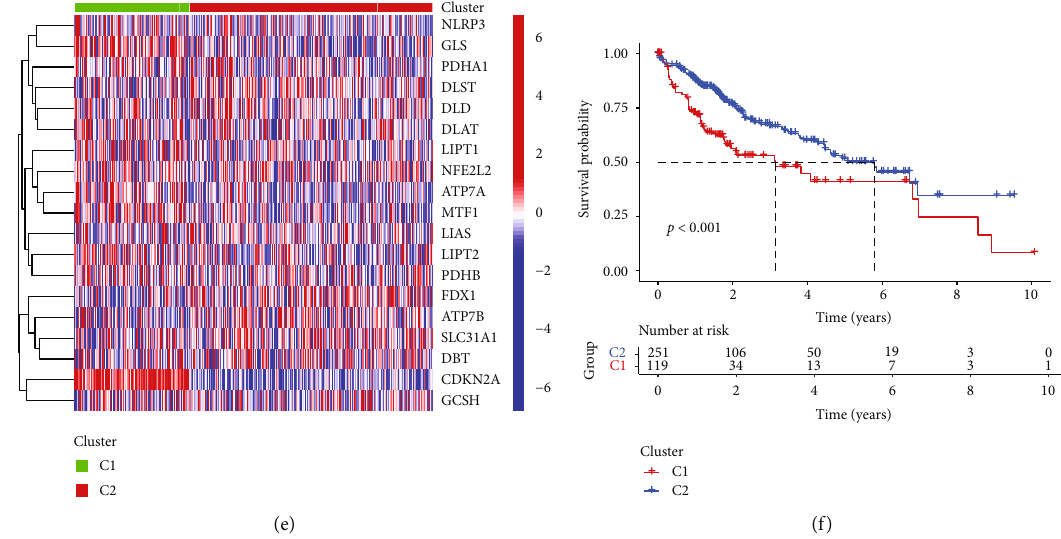
Figure 2: Consensus clustering of cuproptosis-associated subtypes and survival analysis in the TCGA. (a) Heatmap represented the consensus clustering solution ( k = 2 ) for 19 CRGs among 502 HCC samples. (b, c) The consensus clustering delta area showed the cumulative distribution function area for k = 2 to 9. (d) Boxplots represented gene expression pro fi les for 19 genes in the two clusters. (e) An expression heatmap showed 19 genes grouped into two clusters. The color legend represents the log2 (FPKM) value. Red highlighted the high expression, and blue highlighted the low expression. (f) Kaplan – Meier curves of OS in di ff erent clusters. ∗ p < 0 : 05 , ∗∗ p < 0 : 01 , ∗∗∗ p < 0 : 001